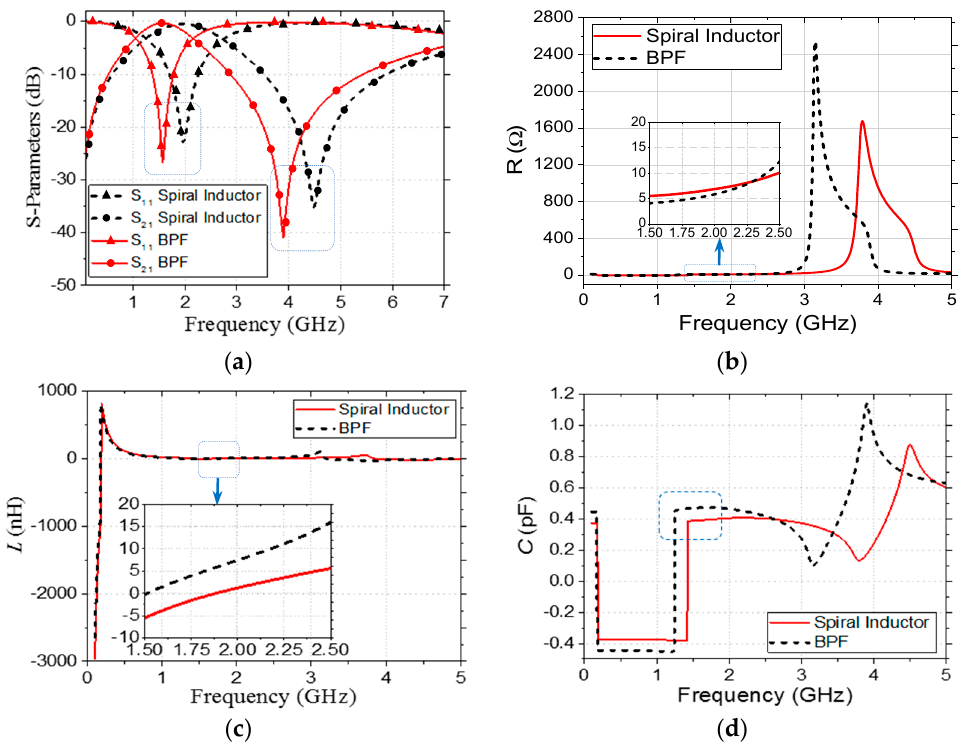
Figure 2. S-parameters and lumped parameters to study the effect of a coupling capacitor. ( a ) Simulated S11 and S21; ( b ) resistance ( R ); ( c ) inductance ( L ); and ( d ) capacitance ( C ).